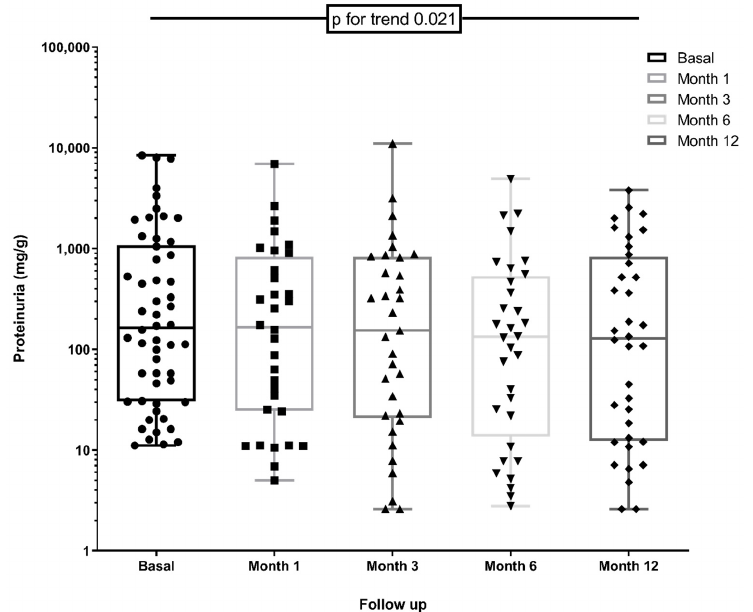
Figure 2. Changes in UPCR during follow-up from baseline (no PCKS9i treatment). Logarithmic plots showing median values and min/max range. Only patients with proteinuria > 10 mg/g ( n = 57) are represented. Changes in proteinuria were assessed using linear models for repeated variables, showing a significant trend during 1-year follow-up.